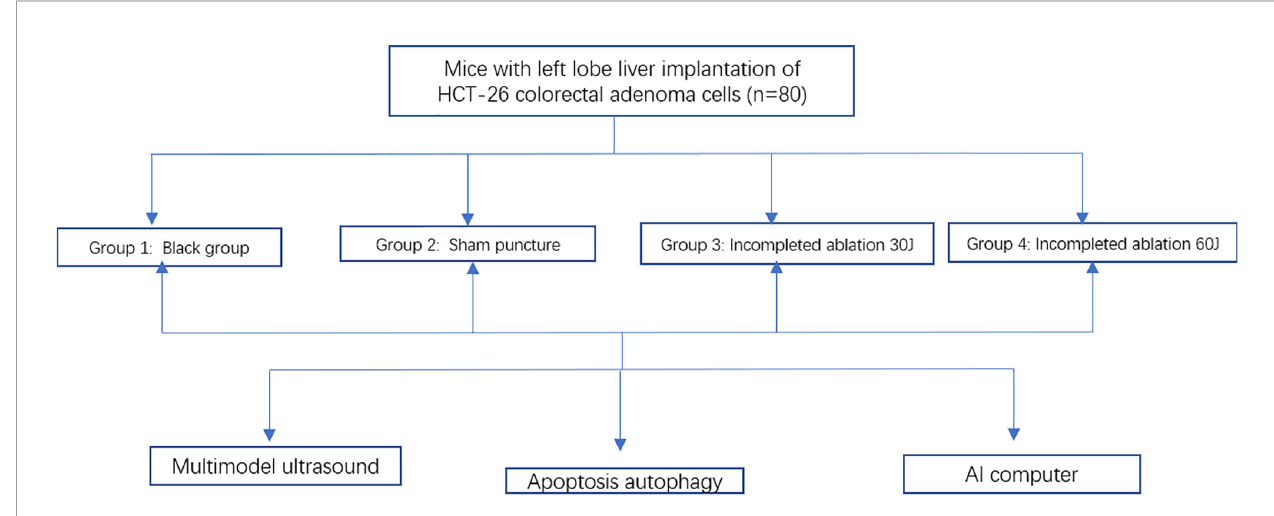
FIGURE 3 | The fl ow chart shows the three main steps process in our